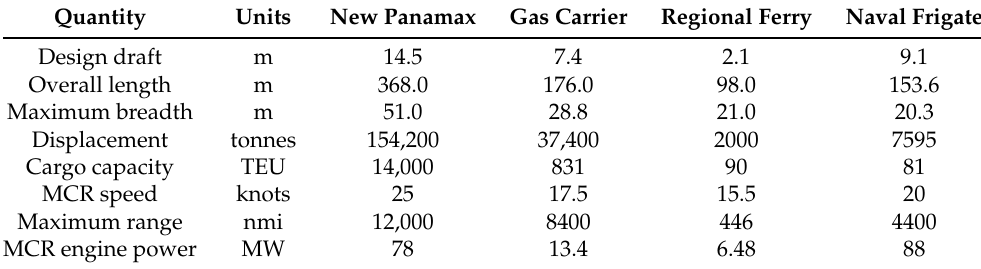
Table 2. The physical characteristics, engine requirements, capacity, and range of each of the four classifications of vessel discussed in the present study [24–32]